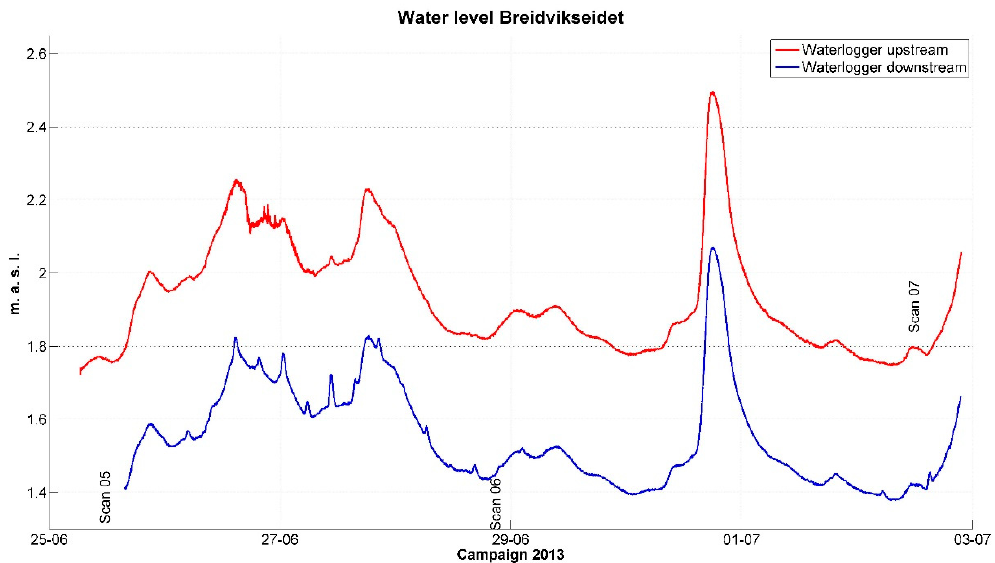
Figure 2. Water level during the third campaign as measured by the water loggers placed upstream and downstream.